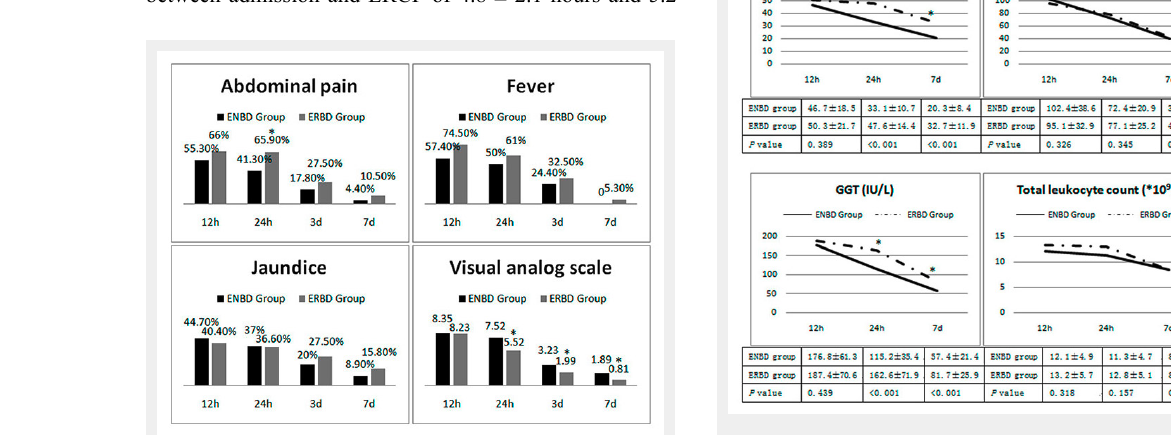
Figure 2 Total bilirubin (TB), alanine aminotransferase (ALT) and gamma- glutamyl transferase (GGT) concentrations and total leucocyte count 12 hours, 24 hours and 7 days after endoscopic retrograde cholangiopancreatography in the endoscopic nasobiliary drainage (ENBD) and endoscopic retrobiliary drainage (ERBD) groups. * p <0.05 vs ENBD group.